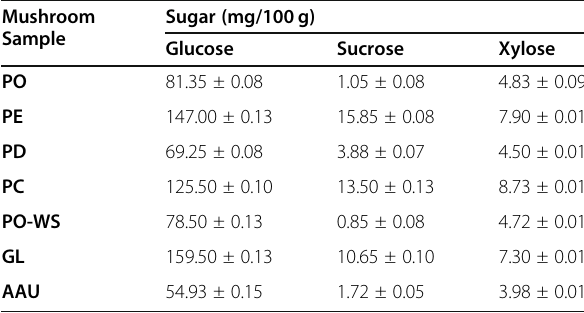
Table 3 Sugar contents of selected Bangladeshi cultivated